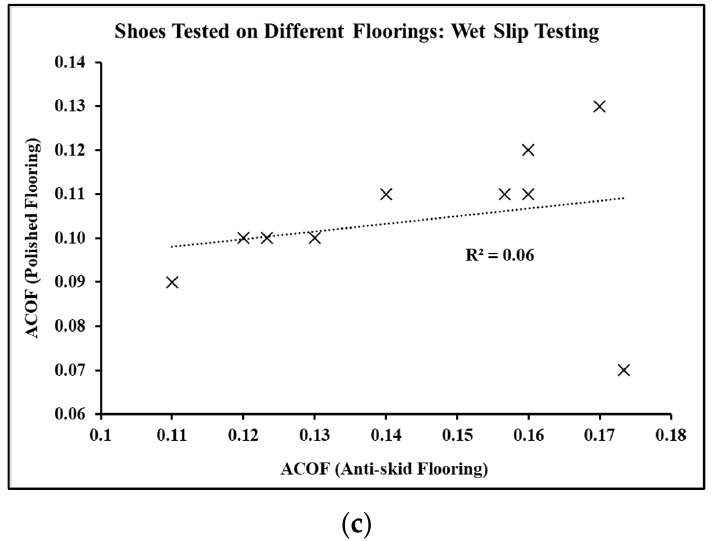
Figure 9. Ability of the slip tester to differentiate shoes tested on different floorings in terms of ( a ) percentage difference in the ACOF between floorings, ( b ) correlation of the ACOF of shoes between floorings in dry condition, and ( c ) correlation of the ACOF of shoes between floorings in wet condi- tion.